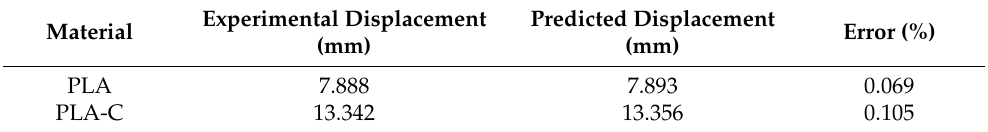
Figure 7. Force–displacement curves for both AFOs as determined by FEA and experimental testing.